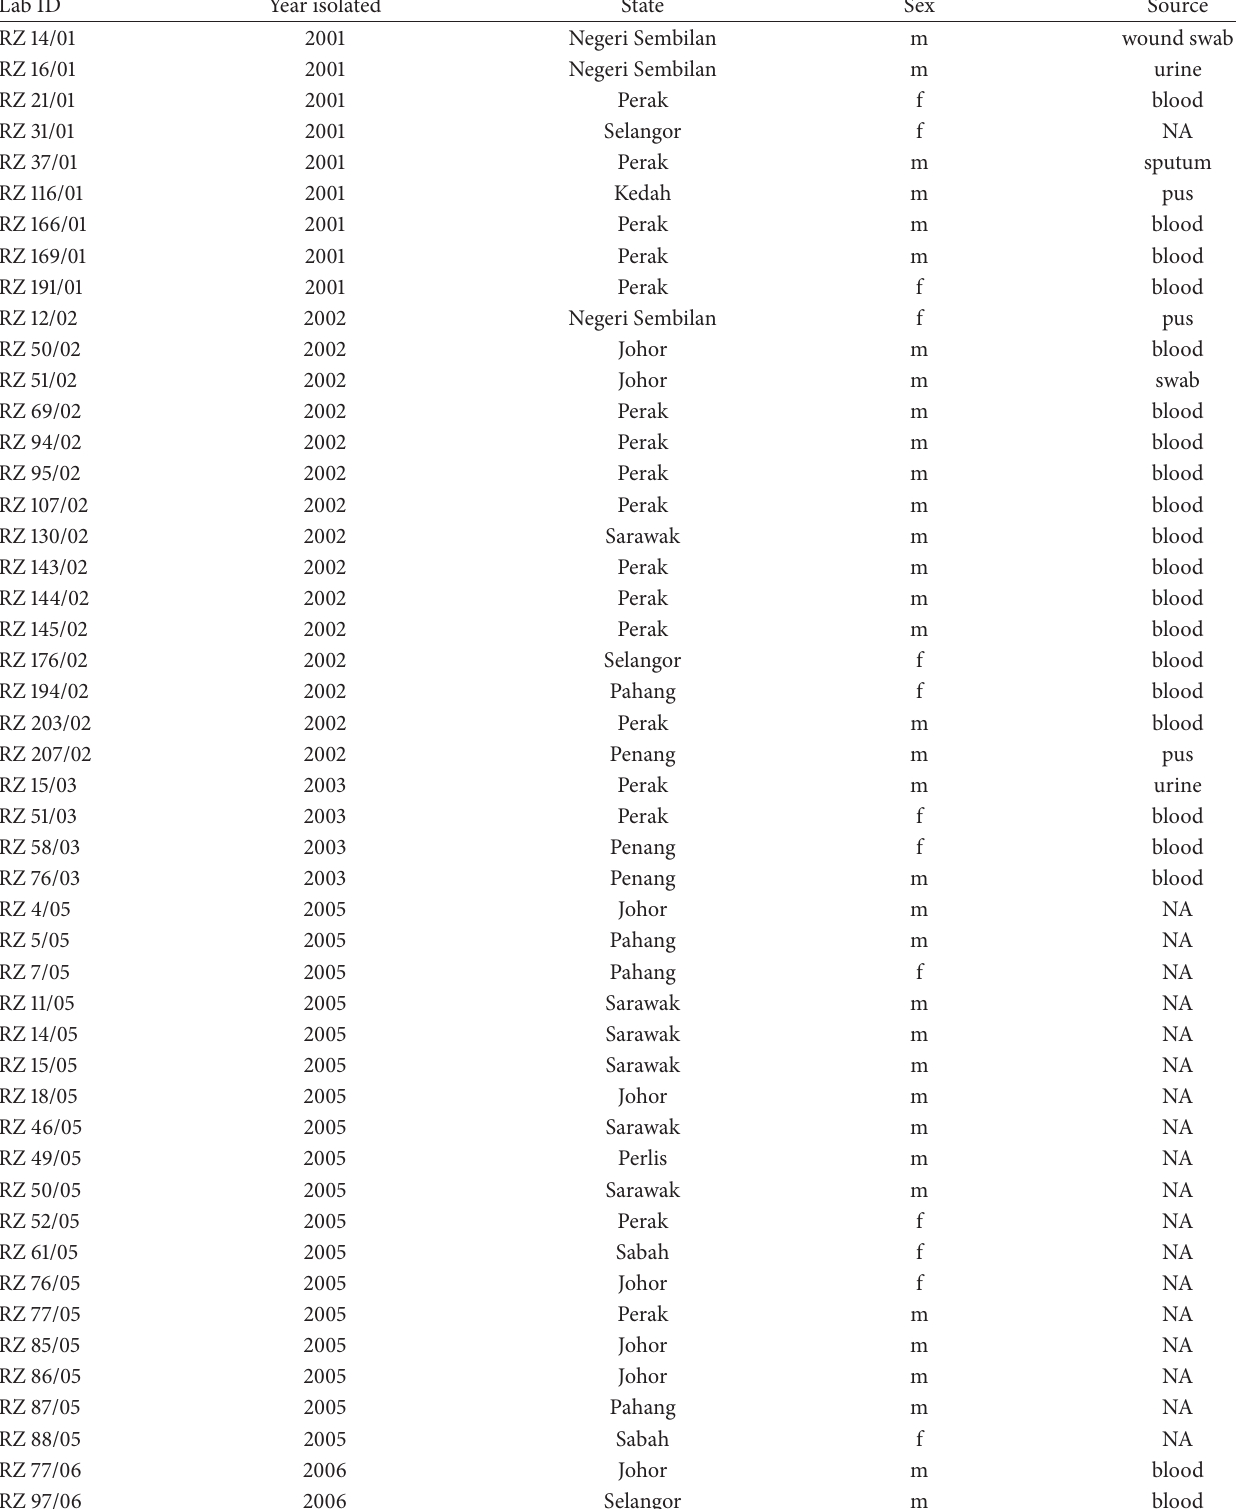
Table 1: The information on the strains used in this